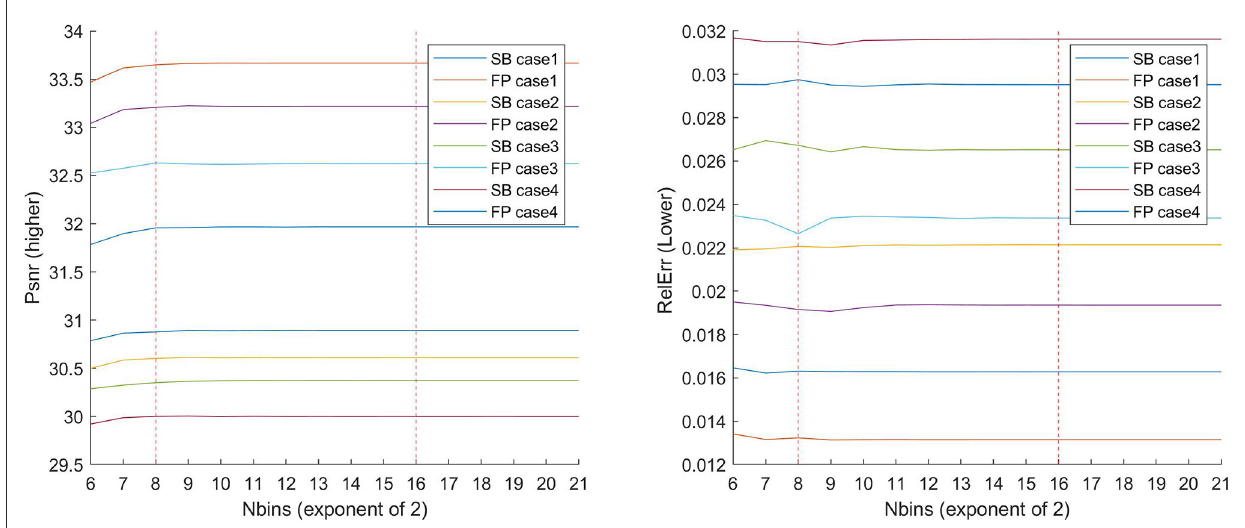
FIGURE6 Graph demonstrating why we use levels of 2 8 or 2 16 . We investigated what happens to the errors when the number of bins is varied for each of the cases (1,2,3, and 4) with the approximate HM presented in the study. In the literature, either 2 8 or 2 16 is commonly used. We have increased the interval and shown what happens in between. Higher levels may be a good choice for smaller values, but the main issue with using more levels is the RAM usage, which exceeds 16GB after L = 2 22